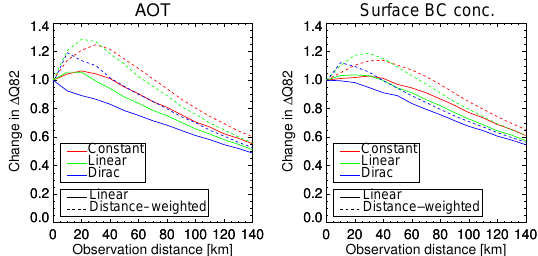
Figure 20. Change (relative to Fig. 14) in (cid:49)q 82 (for monthly rela- tive sampling errors) due to interpolation, as a function of distance to the grid point. All three weighting functions and two interpola- tion methods are considered. Similar graphs for (cid:49)q 50 and (cid:49)q 96 can be